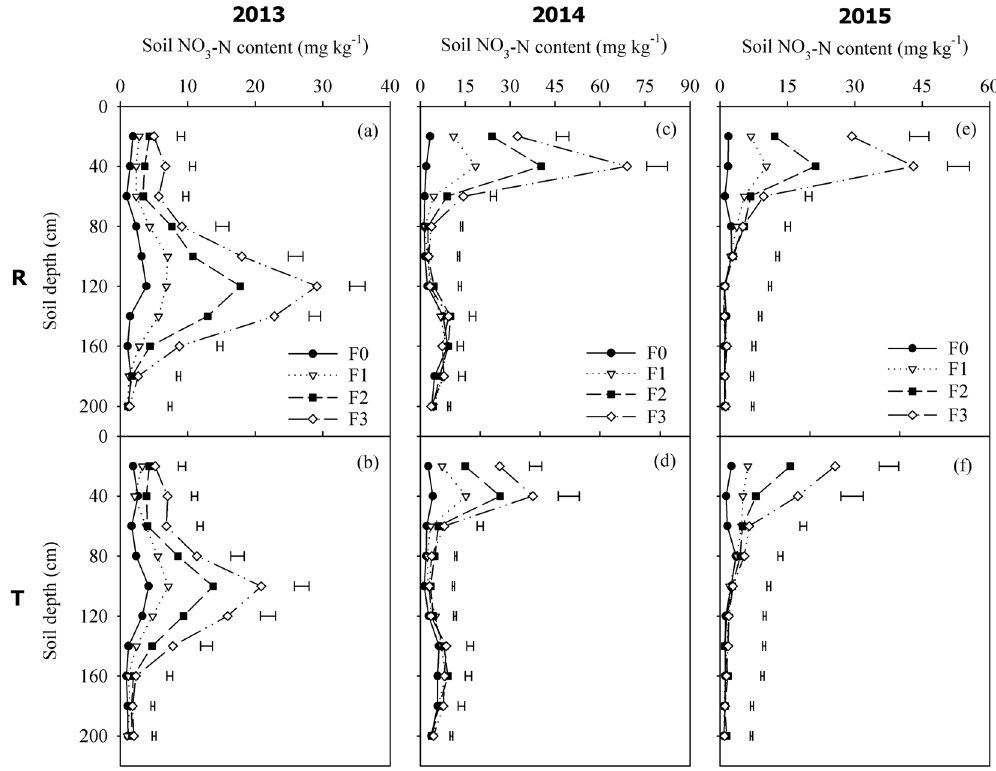
Figure 2. Soil NO 3 -N content at anthesis in the 0–200 cm soil layers according to the fertilizer rate under two planting patterns during 2013–2015. Note: R = ridge and furrow rainfall harvesting planting; T = traditional flat planting; F0, F1, F2, and F3 represent N:P at 0:0, 93:48, 186:96, and 279:144 kg ha − 1 , respectively. Horizontal bars represent the LSD values at the P = 0.05